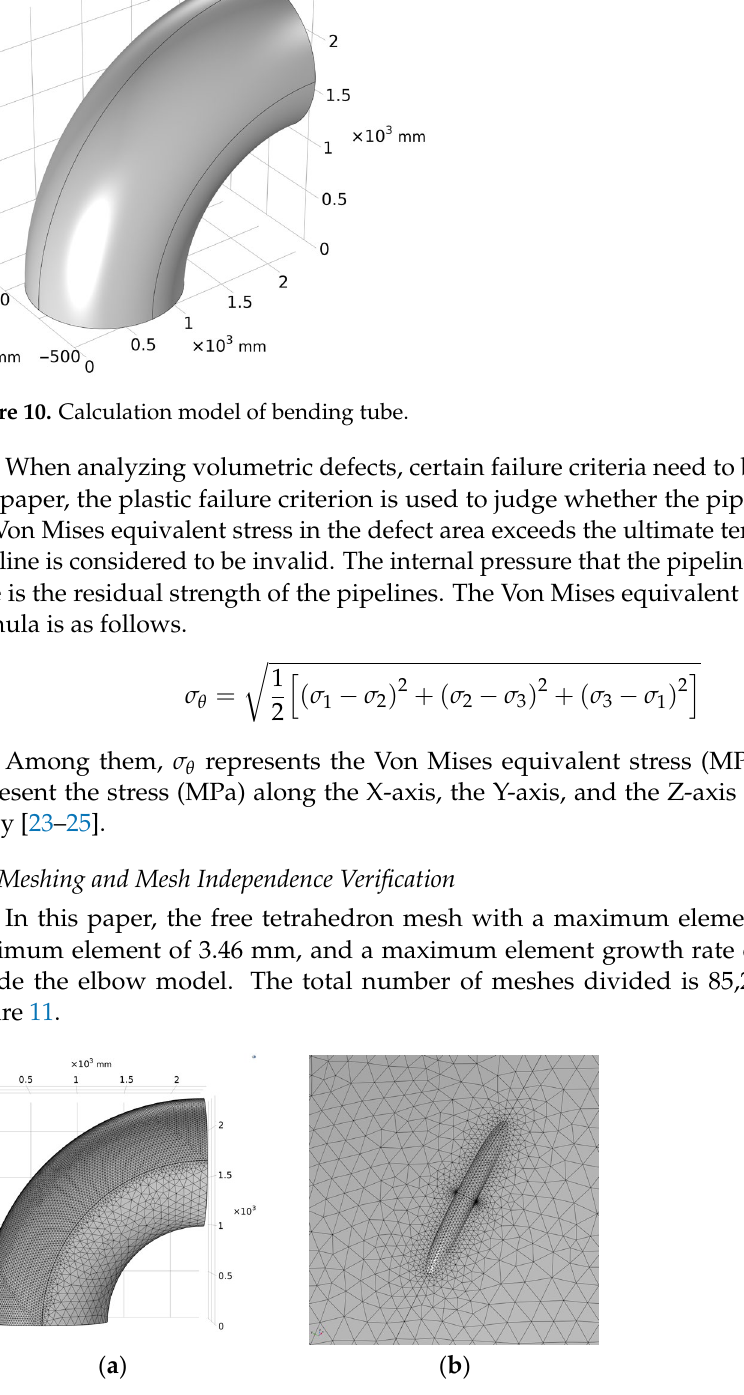
Figure 12. Mesh-independent validation of strength model. 4.3. Numerical Method Validation Collect the real data of seven groups of pipeline blasting tests with defects in the literature [26–28] and calculate the residual strength of pipelines with defects with differ- ent parameters according to the established finite element model. The specific parameters and calculation results are shown in Table 3.